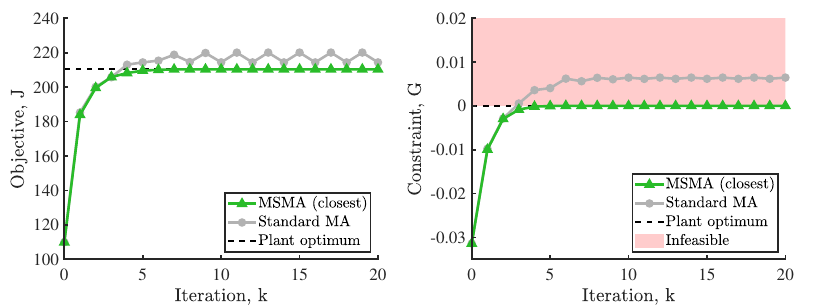
Figure 7. WO case study using the closest solution selection method, compared to standard MA using the same input